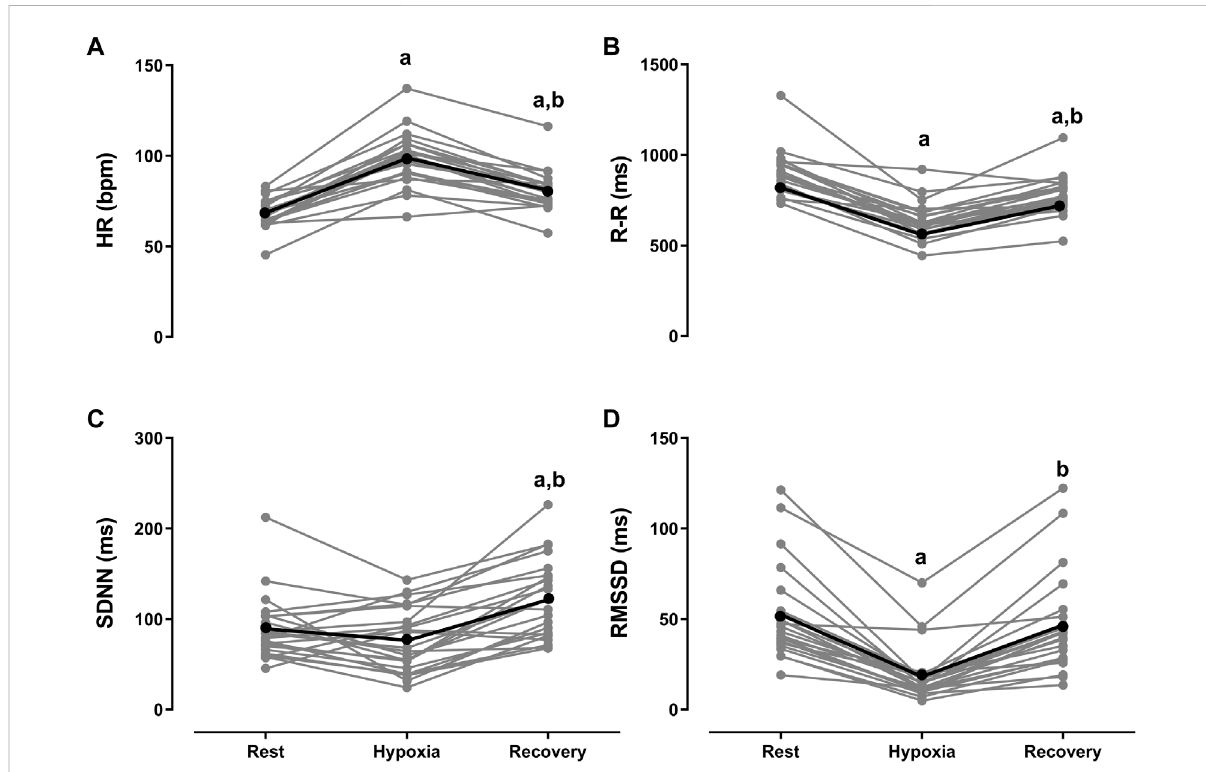
FIGURE 2 Kruskal-Wallis test followed by Dunn ’ s post-test for multiple comparisons. Data expressed as mean ± standard deviation. Ms, milliseconds. (A) HR (bpm) — mean heart rate in beats per minute. (B) R-R (ms) — mean of R-R intervals in milliseconds. (C) SDNN (ms) — standard deviation of RR intervals in milliseconds. (D) RMSSD (ms) square root of successive differences between R-R intervals in milliseconds. a p < 0.0001 vs rest. b p < 0.0001 vs